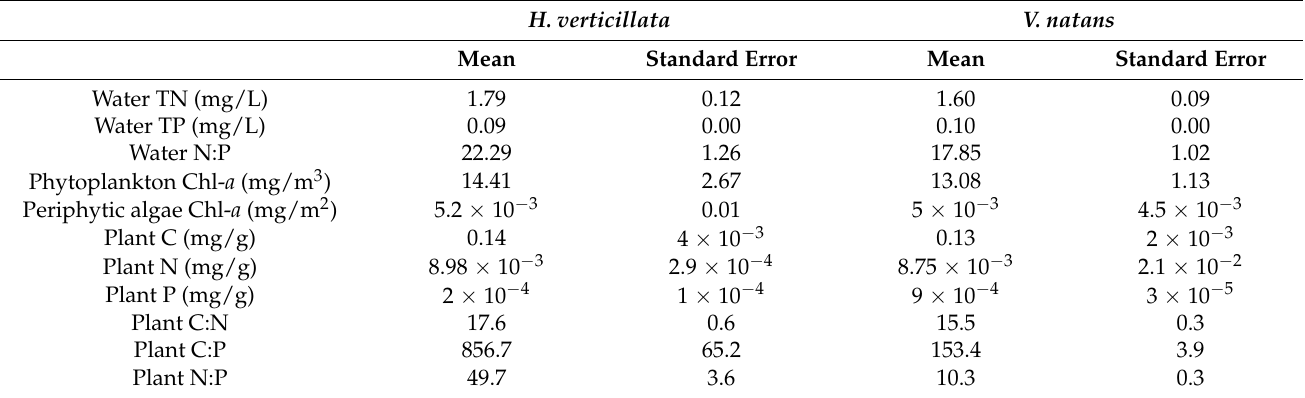
Table 1. Mean values of environmental parameters and stoichiometric traits of submerged plants.